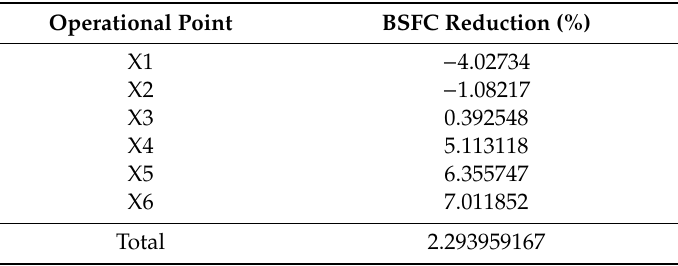
Table 7. T/C analytical BSFC reduction. Table 7. T / C analytical BSFC